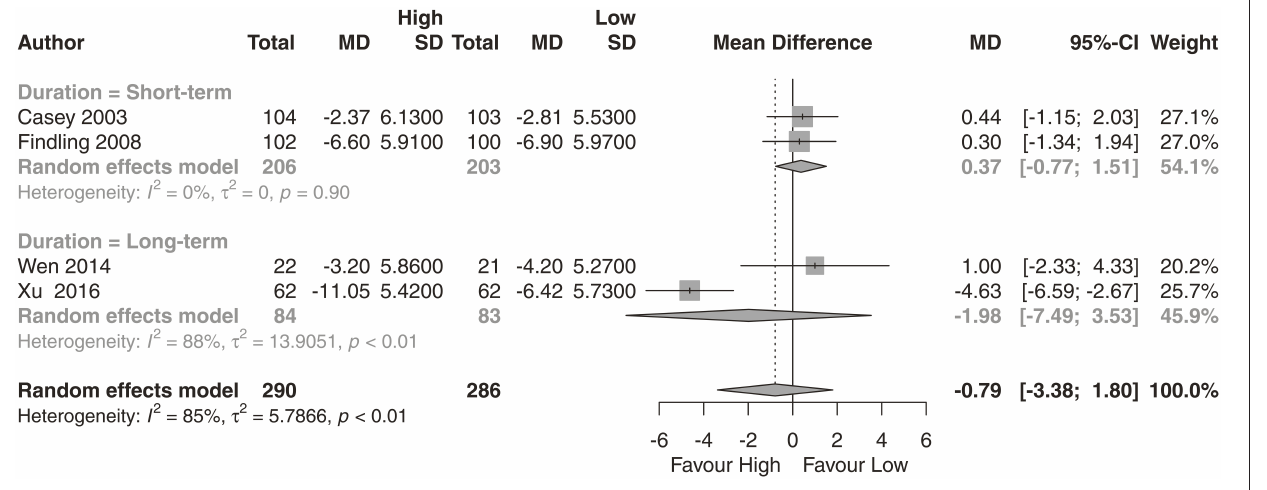
FIGURE 4 | PANSS negative score. High, high-dose strategy; Low, low-dose strategy.